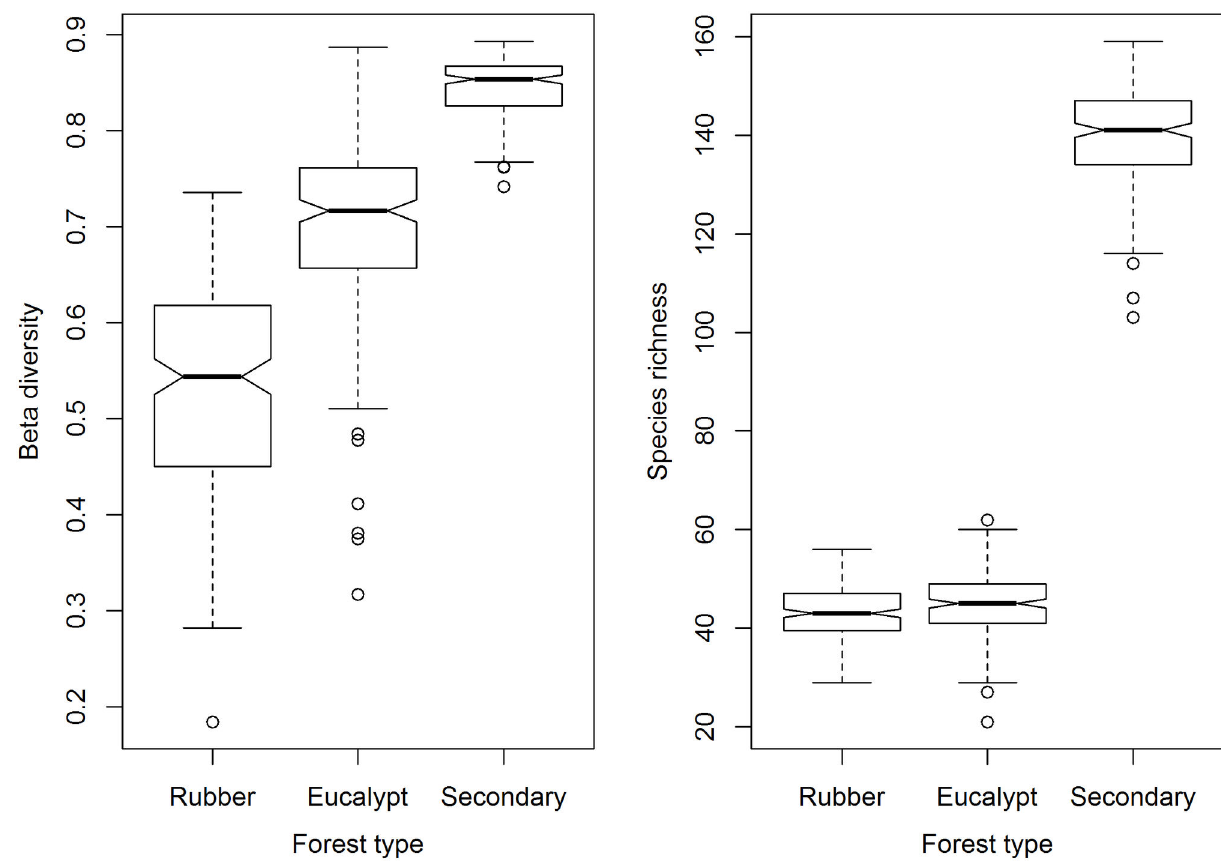
Figure 8. Boxplots of the alpha and beta diversity values for the three types of forests. doi: